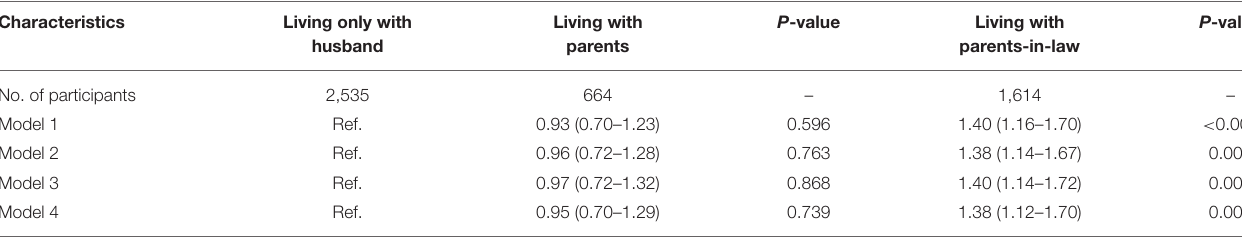
TABLE 2 | OR (95% CI) of postpartum depression according to puerperal women’s living situation.